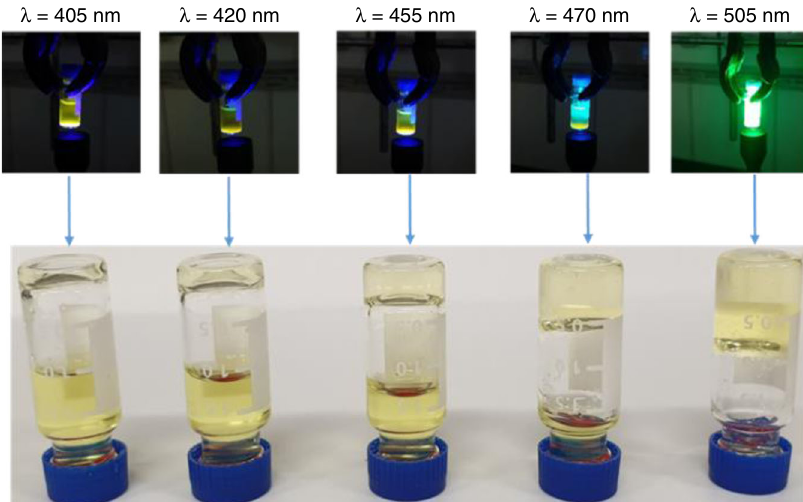
Fig. 6 Effect of light penetration depth on hydrogel thickness. Photographic images of gels formed under irradiation at different wavelengths ( λ = 405 – 505 nm, I = 20 mW cm − 2 ) from a polymer solution ( c = 5 mM) with thickness of 1